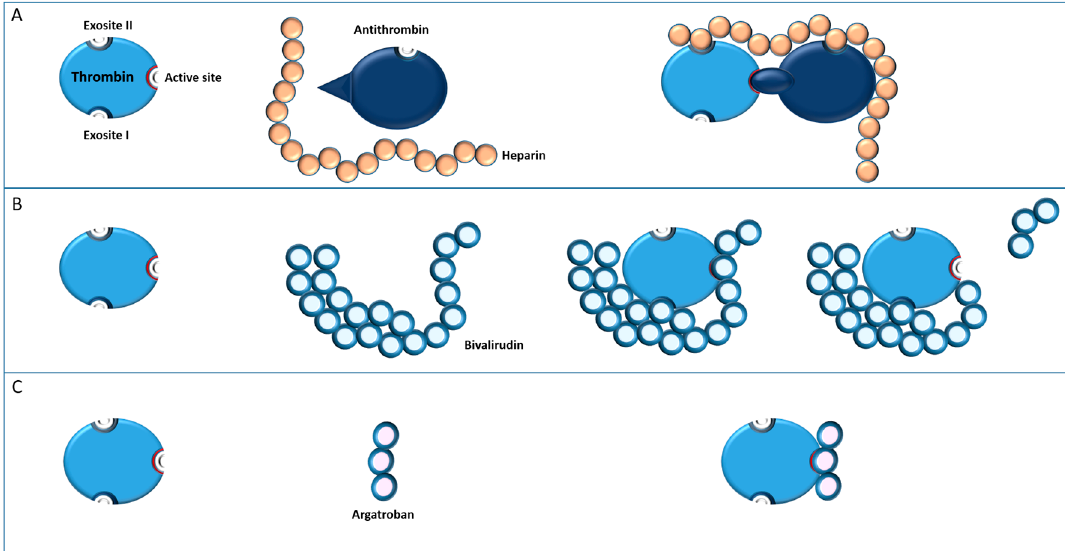
Figure 2. Various thrombin inhibitors with description of main sites of interest: ( A ) indirect inhibition of thrombin by heparin through the intermediate binding to cofactor antithrombin. Of note, binding of antithrombin to thrombin’s active site after heparin increases its affinity, and binding of heparin to thrombin’s exosite II: ( B ) direct inhibition of thrombin by bivalirudin with binding to both active site and exosite I. Binding leads to conformation change and proteolytic cleavage; and ( C ) direct inhibition of thrombin by small peptide argatroban with a unique bound on active site. Exosite I: fibrinogen binding site. Exosite II: heparin binding site.